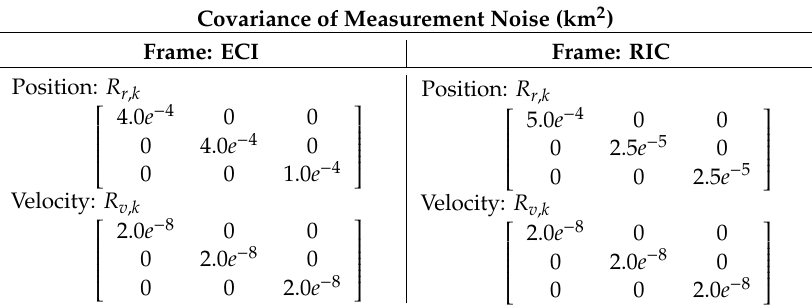
from GPS simulator.